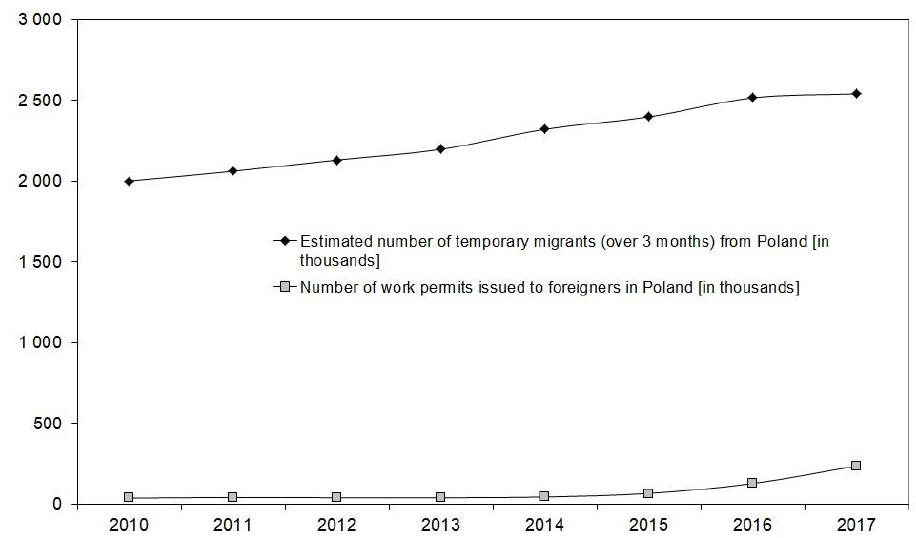
Fig. 5. Estimated number of temporary migrants (over 3 months) [in millions] from Poland and the number of work permits issued to foreigners in Poland [in thousands] (Source: Główny..., 2020; Ministerstwo...,